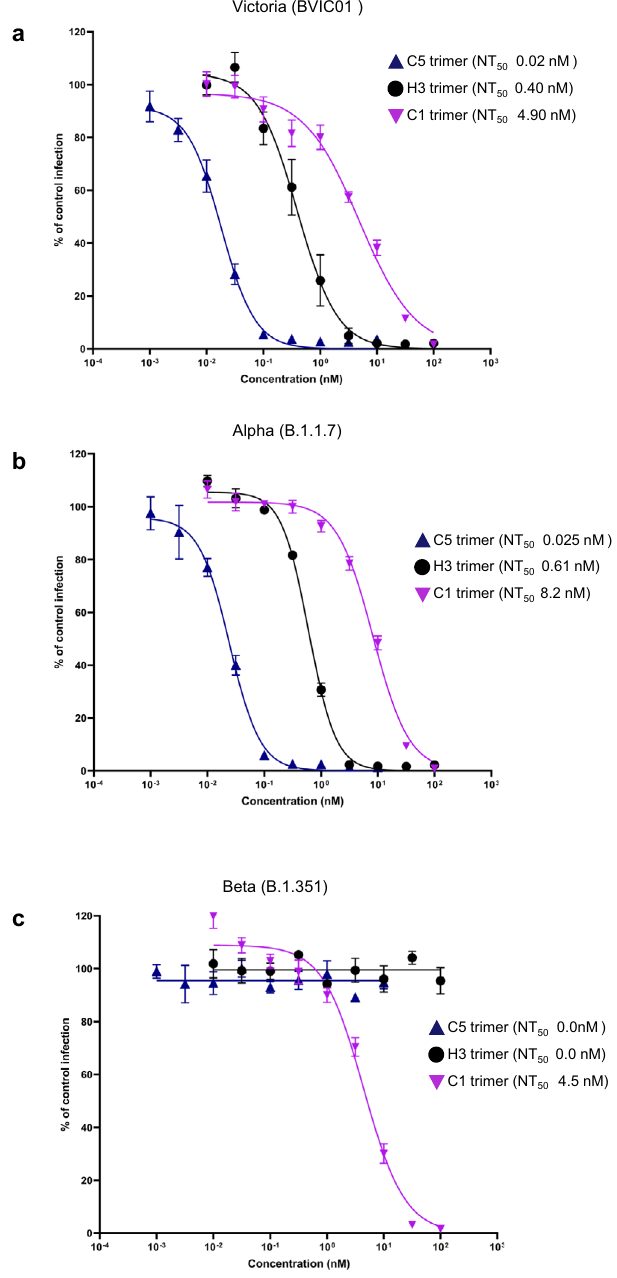
Fig. 5 Neutralisation of SARS-CoV-2 strains in vitro. Neutralisation curves of the anti-RBD nanobody trimers for a Victoria (BVIC01), b Alpha, (B1.1.7) and c Beta, (B1.351) strains of SARS-CoV-2 measured in a microneutralisation assay. Data are shown as the mean ( n = 4) ± 95% intranasally (IN) with SARS-CoV-2 Victoria (5 × 10 4 pfu). The experimental group was treated 24 h later with a single dose of C5-Fc (4 mg/kg) administered intraperitoneally (IP) whilst the control group were left untreated (Fig. 6a). As a measure of disease progression, the animals were weighed each day over 7 days and nasal washes and oropharyngeal swabs were taken every other day (Fig. 6a). On day 7 the animals were culled and viral load in lung, trachea and duodenum measured by subgenomic (sg)-RT-qPCR. Vital organs were formalin- fi xed for histopathology (H&E staining) and ISH RNAScope staining with SARS-CoV-2 S-gene probe to detect presence of virus RNA.